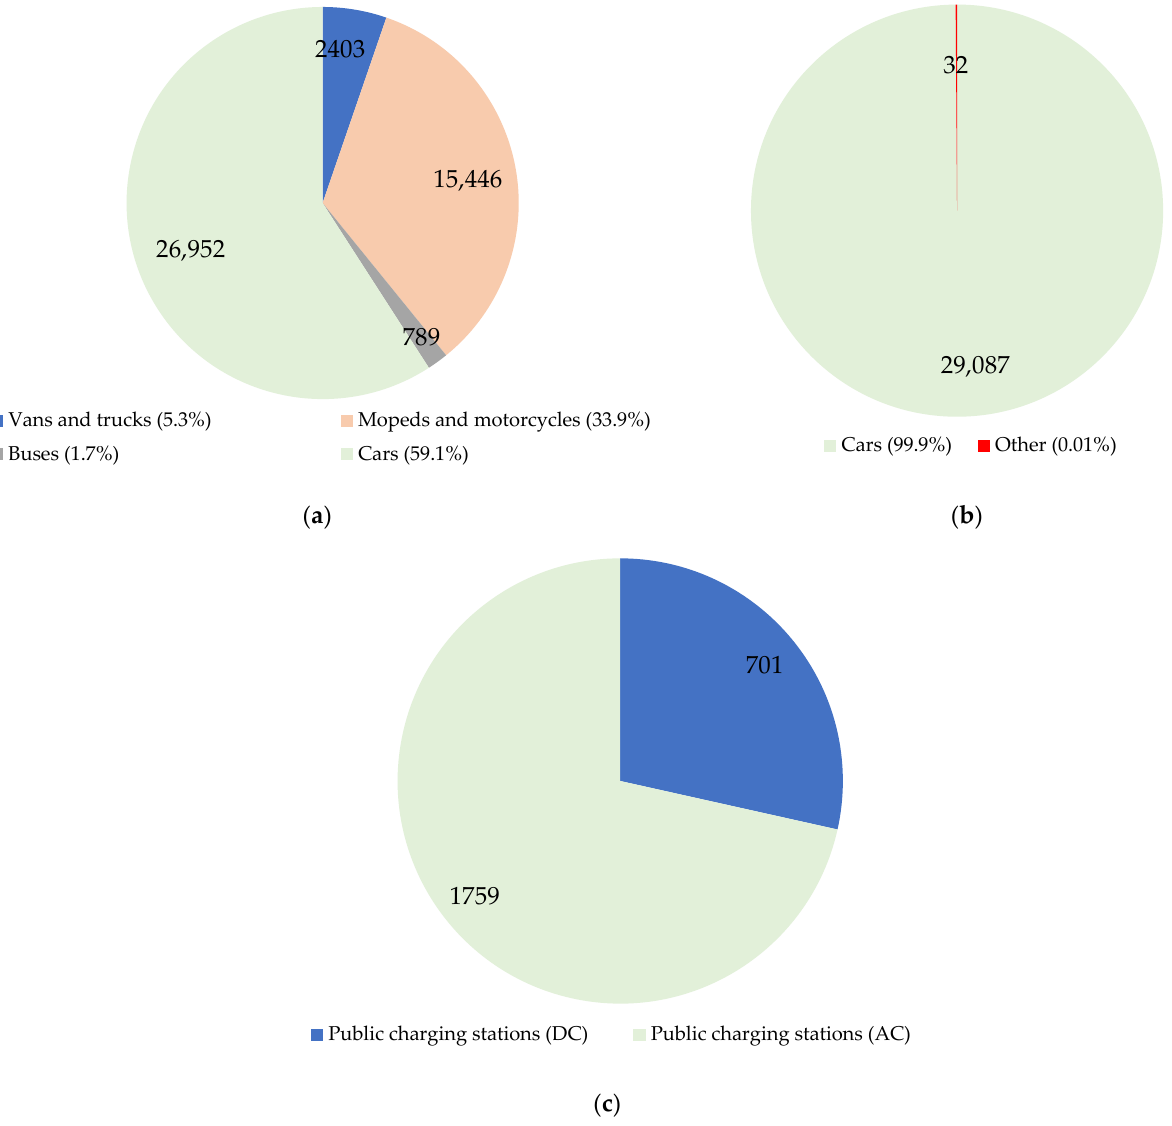
Figure 8. Electromobility in Poland in September 2022: ( a ) BEV all-electric vehicles; ( b ) PHEV plug-in hybrids; ( c ) Charging infrastructure.